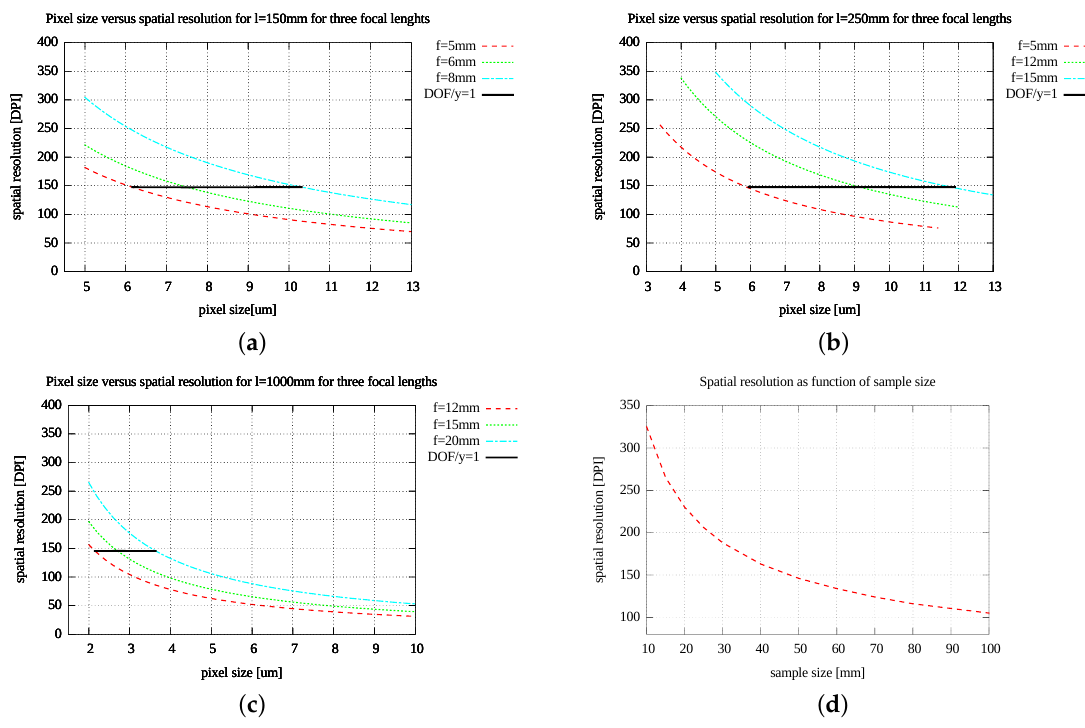
Figure 6. Spatial resolution in dots per inch (DPI) as a function of the sensor pixel size for the distance l of the object from the sensor ( a ) 150 mm; ( b ) 250 mm; ( c ) 1000 mm. Black line in all three charts indicates the condition DoF = y , for the sample size y = 50 mm; ( d ) Spatial resolution as a function of measured sample size computed for maximum zenith angle θ max = 75 ◦